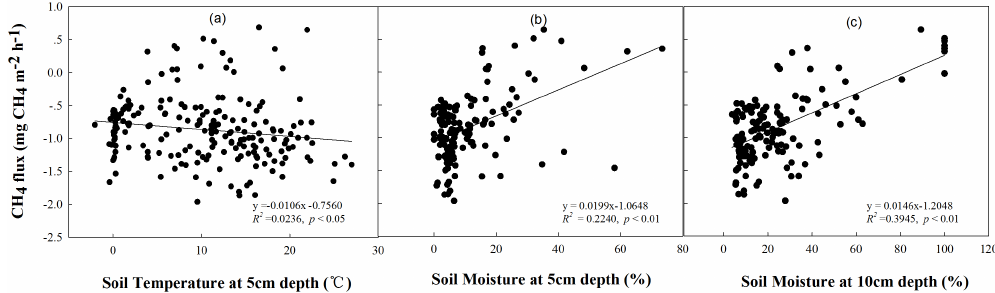
Figure 4. Temporal dependence of CH 4 flux on soil temperature (a) and soil moisture (b, c) across the three growing seasons.